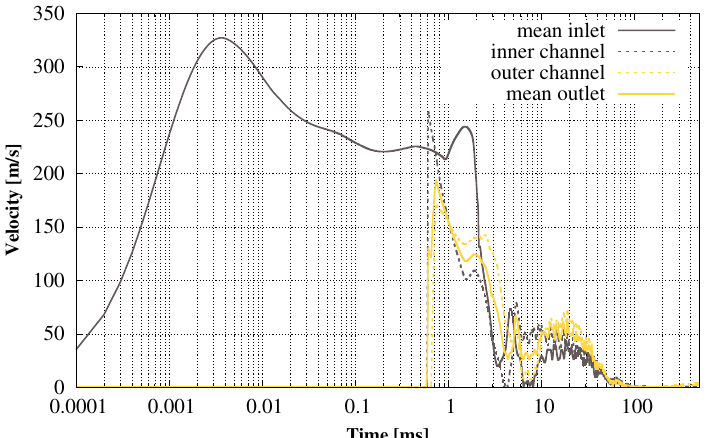
Figure 8. Area-averaged velocity magnitude considering inlet,outlet and each outlet channel of the nozzle.